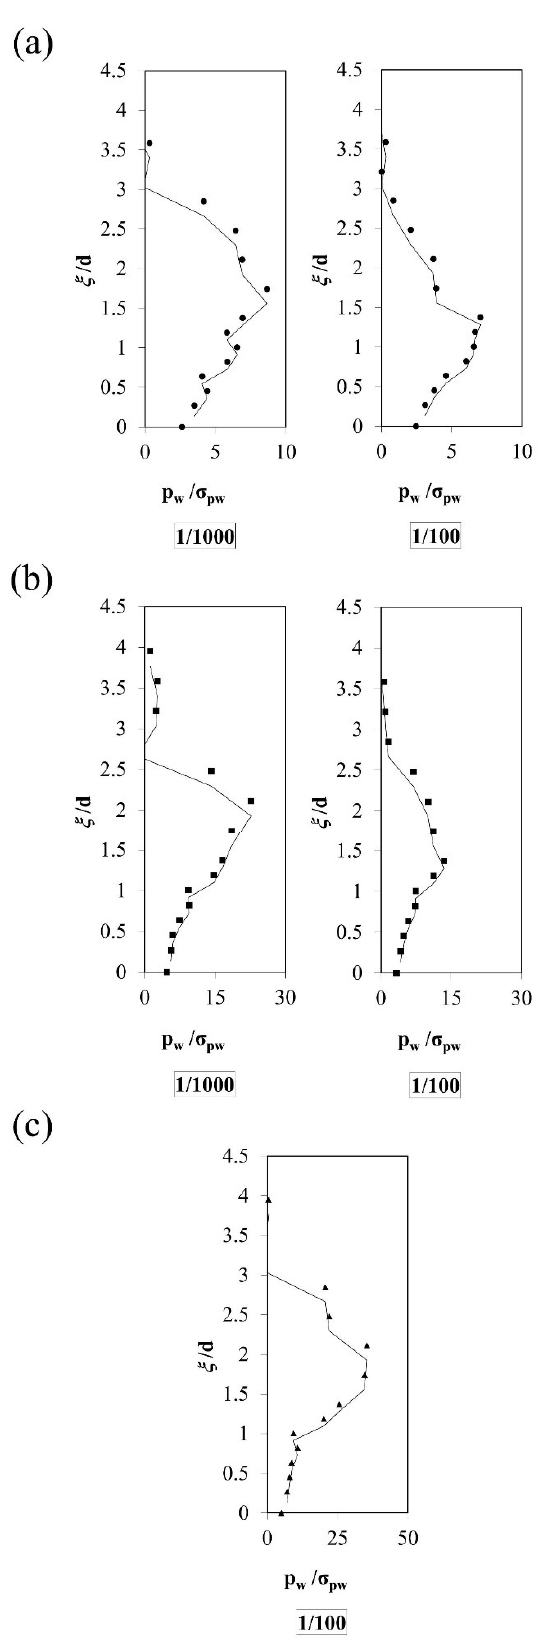
Figure 5. Average wave pressure distribution of the greatest N /1.000 and N /100 positive force peaks )(~ tF of “Quasi-Standing waves” ( a ), of “Slightly Breaking waves” ( b ) and of “Impact Loads” ( c ).